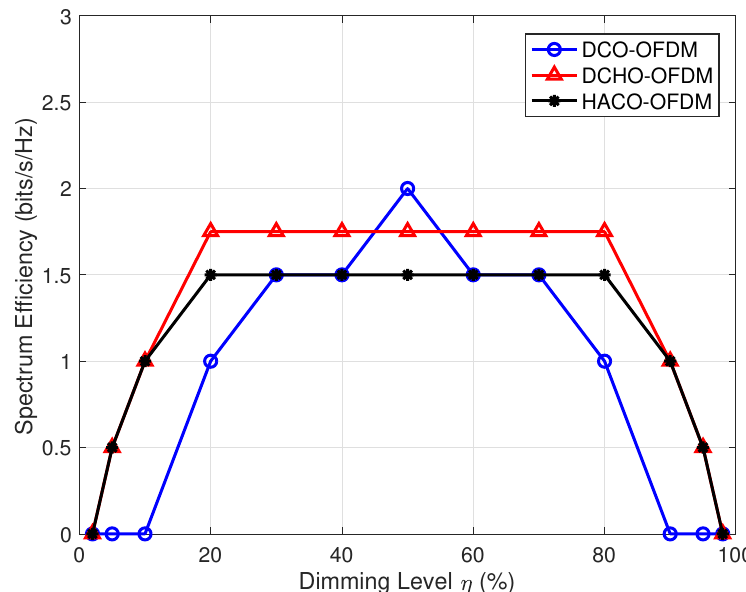
Figure 7. The achievable spectrum efficiency as a function of dimming level η , under a noise power of − 2 dBm.